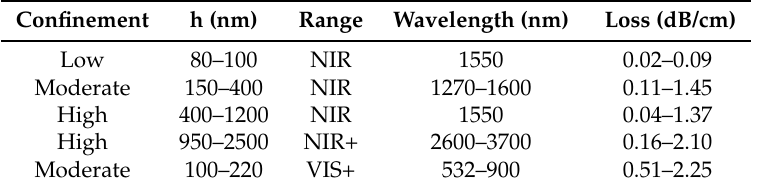
Table 2. Summarized comparison of silicon nitride strip waveguide platforms.